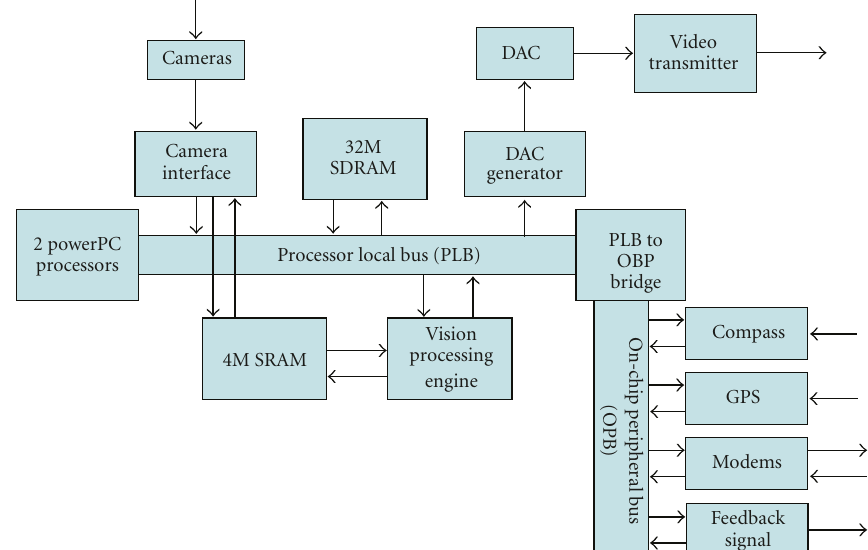
Figure 4: FPGA hardware architecture.